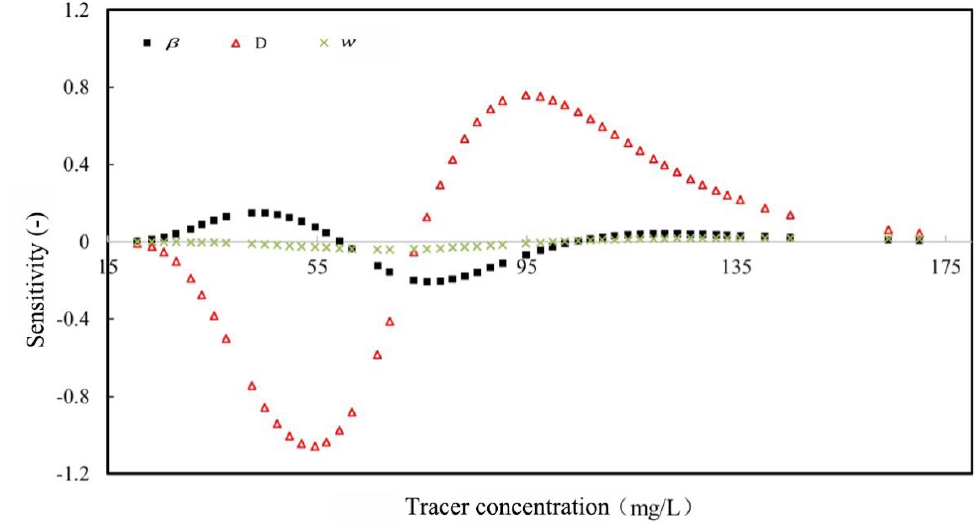
Figure 7. Sensitivity of MIM parameters to different tracer concentrations.